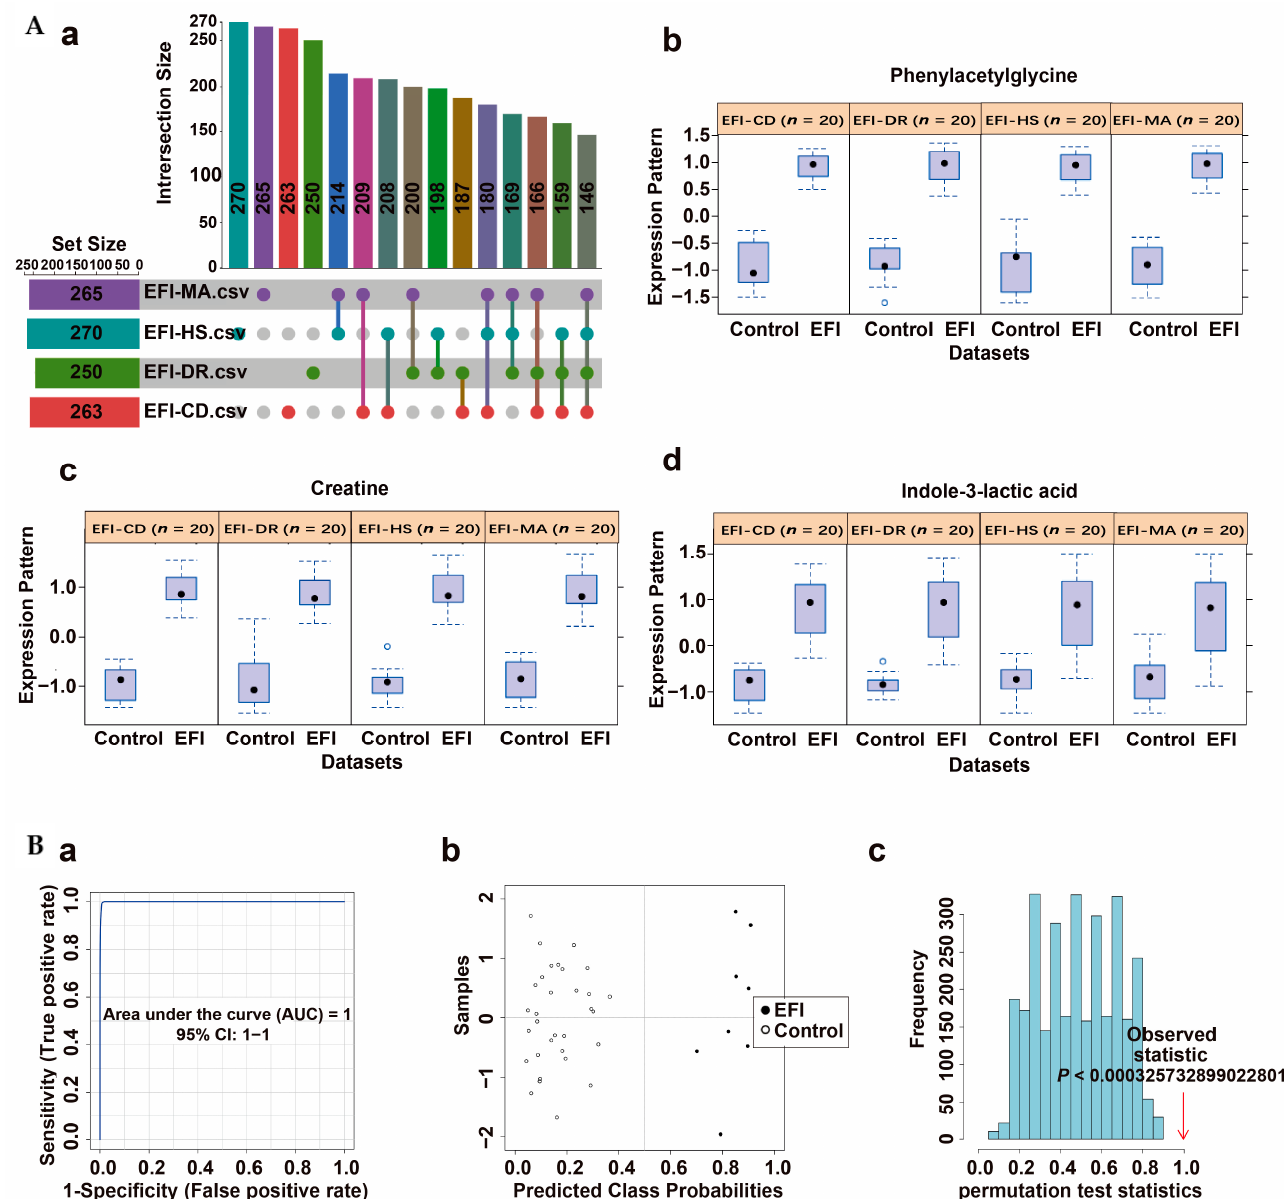
Figure 3. Screening classification model in plasma samples from the EFI group relative to the NDRDs group. ( A ) ( a ) Upset plots obtained with biomarkers meta-analysis of EFI and four NDRD groups (total of 5 groups, n animal = 10, respectively), with 146 common differential metabolites. ( b – d ) The classification model consisted of three candidate differentials, phenylacetylglycine, creatine and indole-3-lactic acid, and they were significantly up-regulated in the EFI group. ( B ) Discriminatory ability evaluation of the EFI classification model in the training set (n EFI = 8, n NDRDs = 32). ( a ) ROC plot: AUC = 1 (95% CI: 1 − 1) ( b ) Confusion matrix plot showing samples without misclassification. ( c ) Classification model with 100 permutation-test plots, p < 0.01. Notes: ( B ) construction and evaluation of classification models using multivariate ROC curve analysis based on linear SVM algorithm. ( a – c ) in ( B ) respectively represent: ( a ) the area under the ROC (AUROC (AUC)) of the classification model in different datasets contains the AUC-value and its 95% confidence interval (CI). ( b ) The confusion matrix showed the average of predicted class probabilities between EFI and different controls; the classification boundary was at the center dotted line of x = 0.5. ( c ) Permutation tests using the model’s predictive accuracy as a measure of performance. The plots showed the actual observed AUC of all permutations and p value.